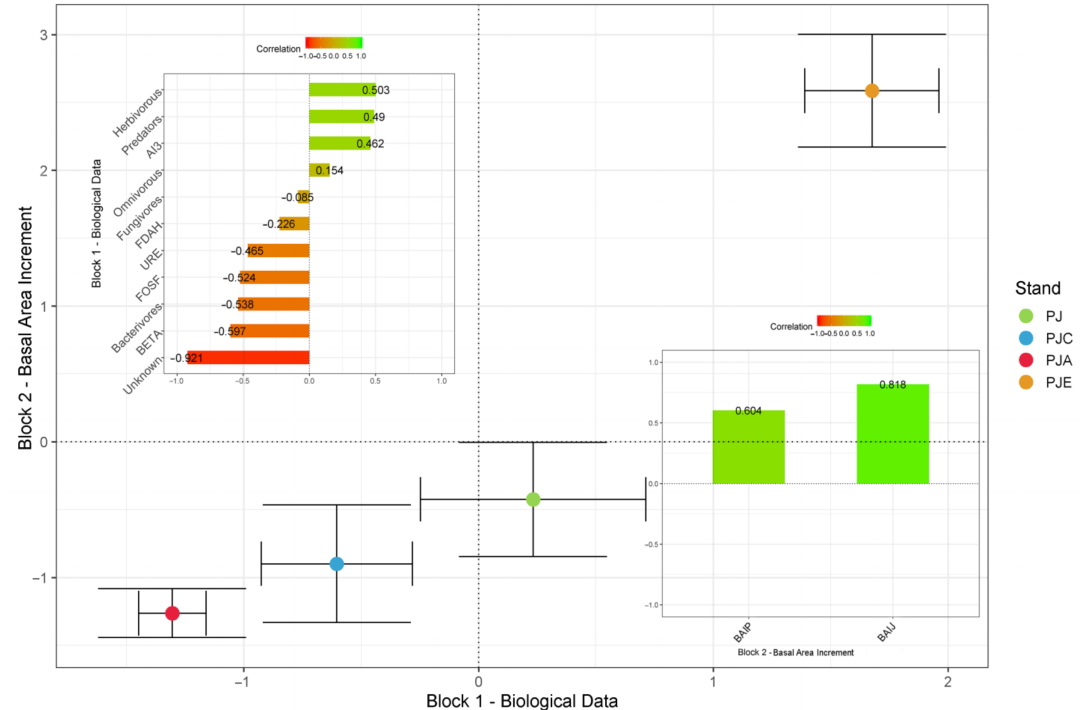
Figure 6. Scatterplot for the first axis of the 2B-PLS. Points are mean ± standard error across Block 1 (biological data) and Block 2 (basal area increment). The insets show the correlation within and between blocks of the